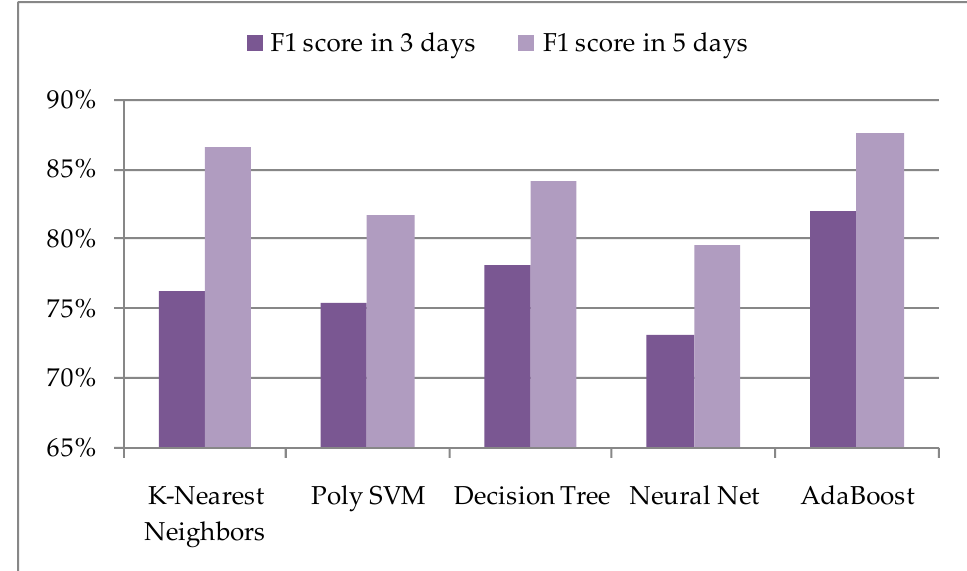
Figure 5. F1-scores according to an extended method with selected ML algorithms.